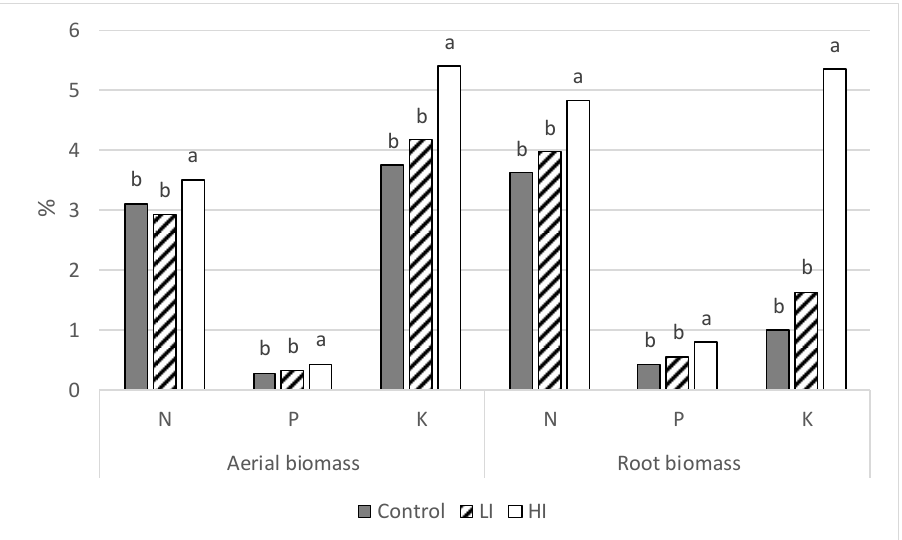
Figure 5. Effect of non-thermal-plasma-activated nutrient solution on the concentration of nitrogen, phosphorus, and potassium (dry weight basis) in the aerial and root biomass of lettuce. Within each parameter, values with different letters are significantly different at p < 0.05 based on a Tukey test (HSD).